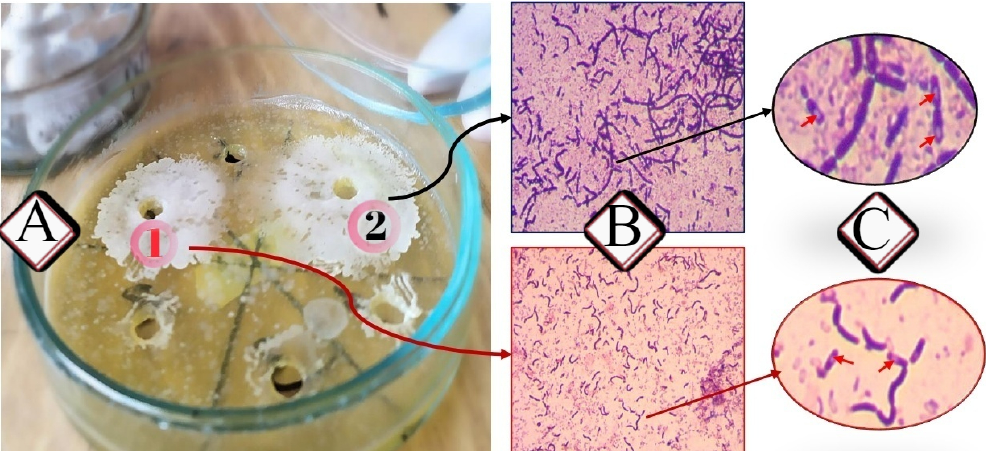
Fig. 1. Manifestation of antagonism of the studied kinds of honey against the test culture of enterobacteria of bees of Klebsiella pneumoniae species. (A) cultural characteristics of bacteria – antagonists determined by agar well diffusion method (1. forest honey; 2. acacia honey), (B) microscopic view of bacteria – antagonists under microscopy (Gram method) x 1000, (C) endo- spores of bacteria – antagonists of the studied kinds of honey x 10000